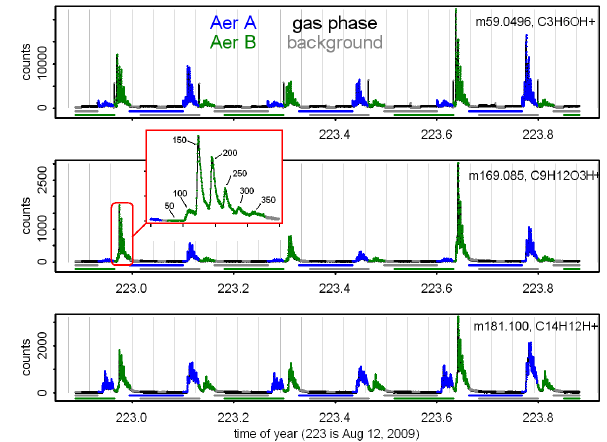
Figure 2. TD-PTR-MS data of 3 ion species over period of 24 hours. Gas phase measurements are printed in black; when zero-air was supplied to the gas inlet the data are printed in grey (background measurement). Blue and green data indicate that aerosol inlet A and B was analysed, respectively. The lines just above the time axis indicate the times of aerosol sampling, the upper line for inlet A and the lower line for inlet B. Grey lines indicate that the sample flow was directed through the aerosol filter (field blank). The peaks associated with temperature levels during aerosol analysis are clearly visible in the insert (the numbers in the insert indicate the CTD cell temperature).